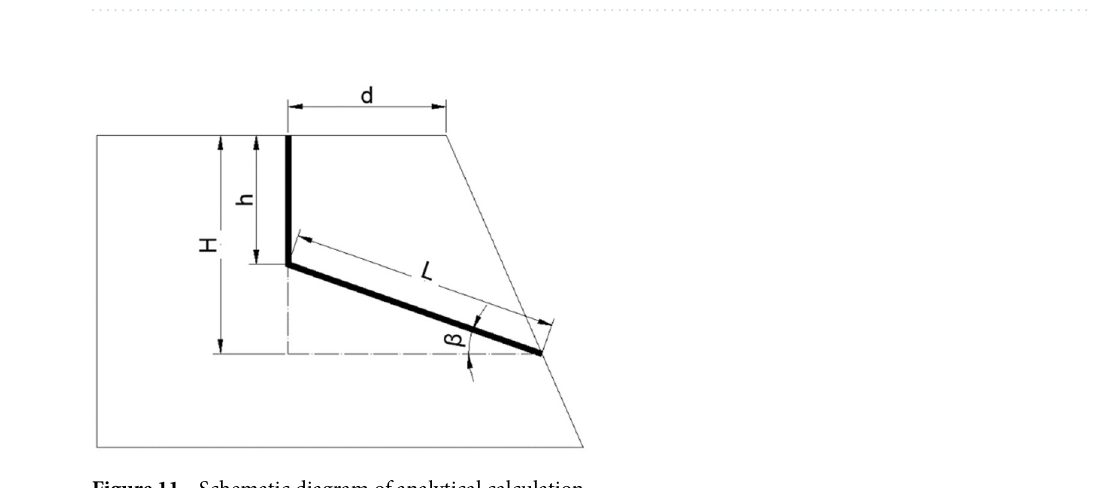
Figure 10. The variation curve of slope safety factor with the dip angle and length of the joint.